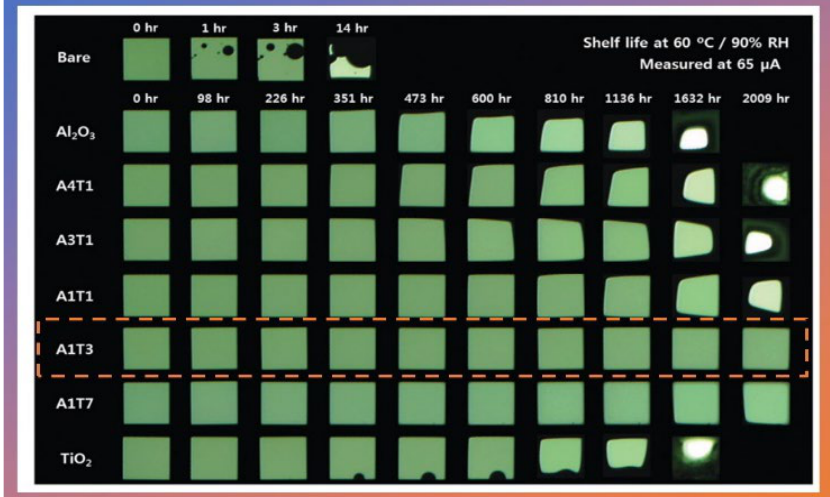
Figure 9. Shelf lives of the OLED devices passivated with and without Al 2 O 3 /TiO 2 nanolaminates grown via PA-ALD. The A1T3 film highlighted represents the 1:1 atomic ratio of Al 2 O 3 /TiO 2 with the lowest WVTR value at 60 °C and 90% of RH. Reprinted with permission from Ref. [82]. Copyright 2016, Royal Society of Chemistry.